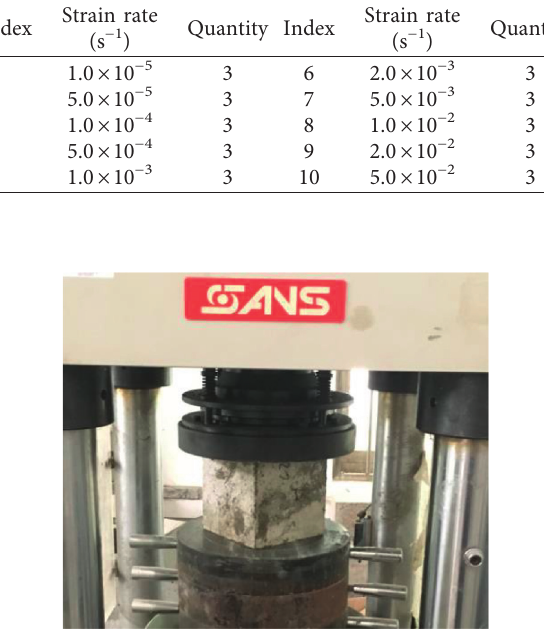
Figure 1: Experiment